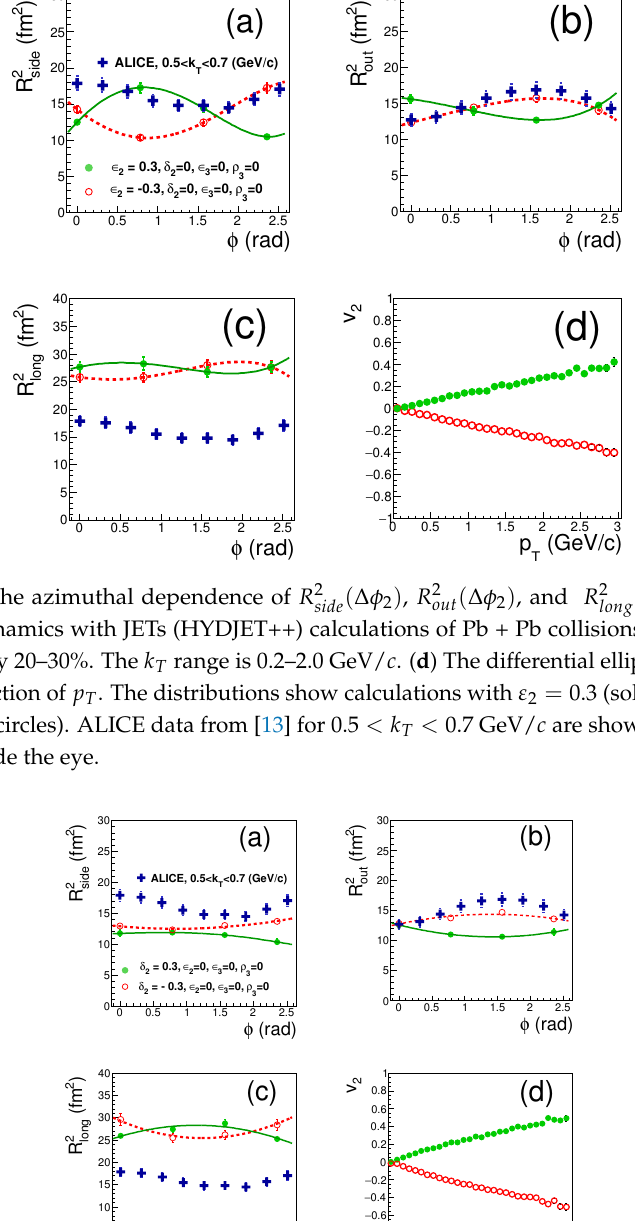
Figure 2. The same as Figure 1, but for calculations with δ 2 = 0.3 (solid circles) and with δ 2 = − 0.3 (open